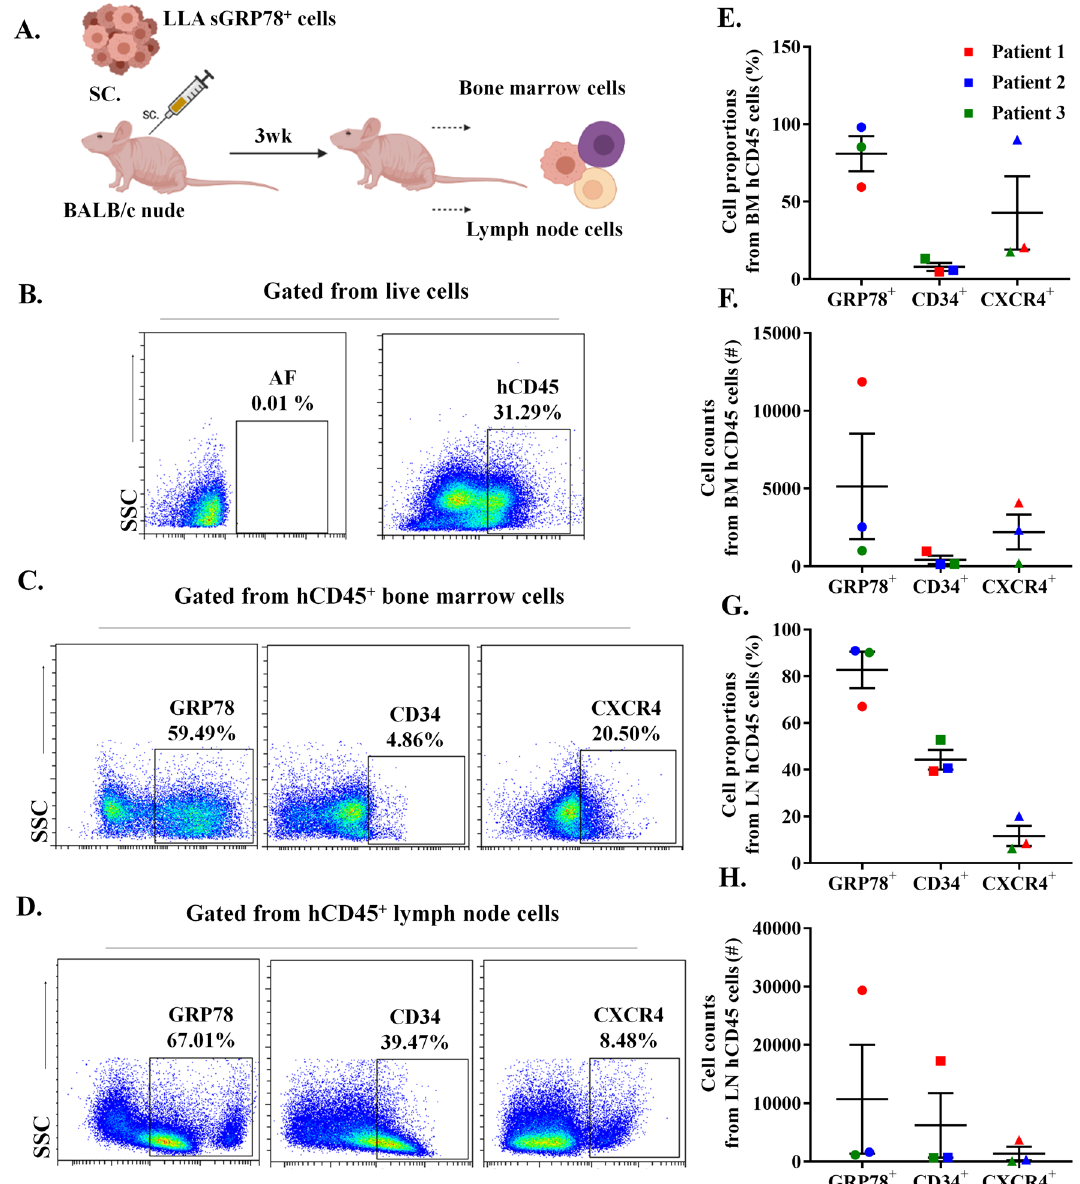
Figure 5. Patient-derived sGRP78 + leukemic cells disseminate in a xenotransplantation model. ( A ) Schematic representation of the methodology used. ( B–D ) sGRP78 + B-ALL human bone marrow cells were sorted from high-risk B-LLA patients and injected into a BALB/c nude immunodeficient mice. Cells from murine bone marrow (BM) and lymph node (LN) were recovered 3 weeks later and were stained with anti-human CD45 (hCD45), anti-CD34 and anti-CXCR4, representative images are depicted. ( E–H ) Percentages and absolute numbers of sGRP78 + , CD34 + and CXCR4 + cells selected from hCD45 fraction, both in BM ( E,F ) and LN ( G,H ) are depicted. AF